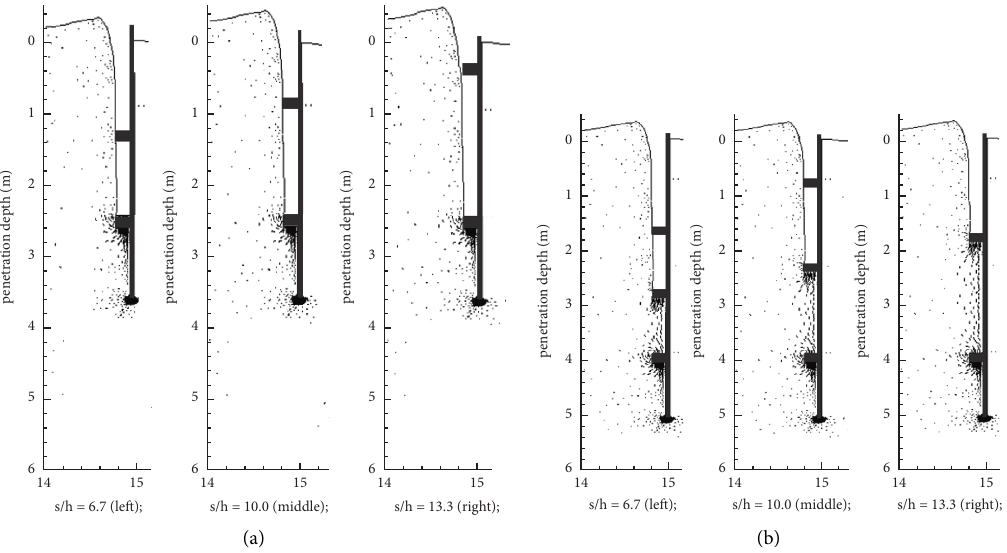
Figure 8: Effect of stiffener height and the distance of stiffeners on soil movement.